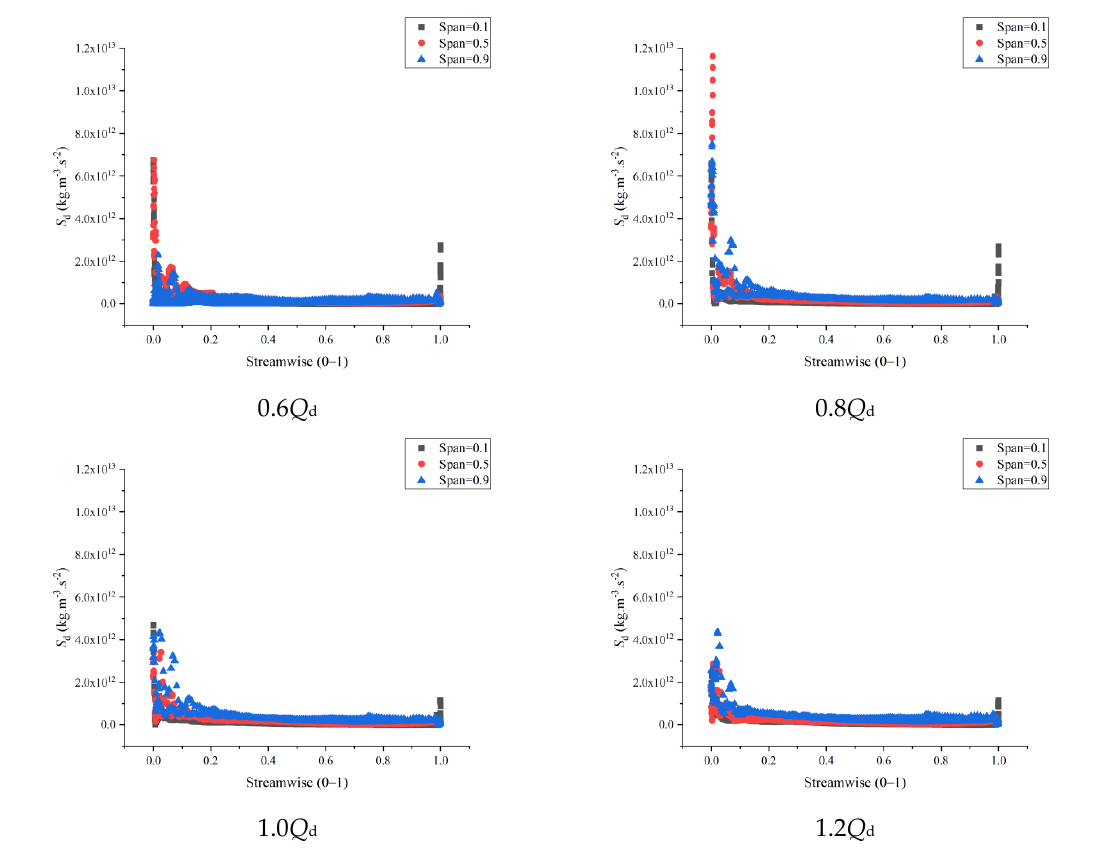
Figure 13. Dipole source distribution on the impeller blade surface.